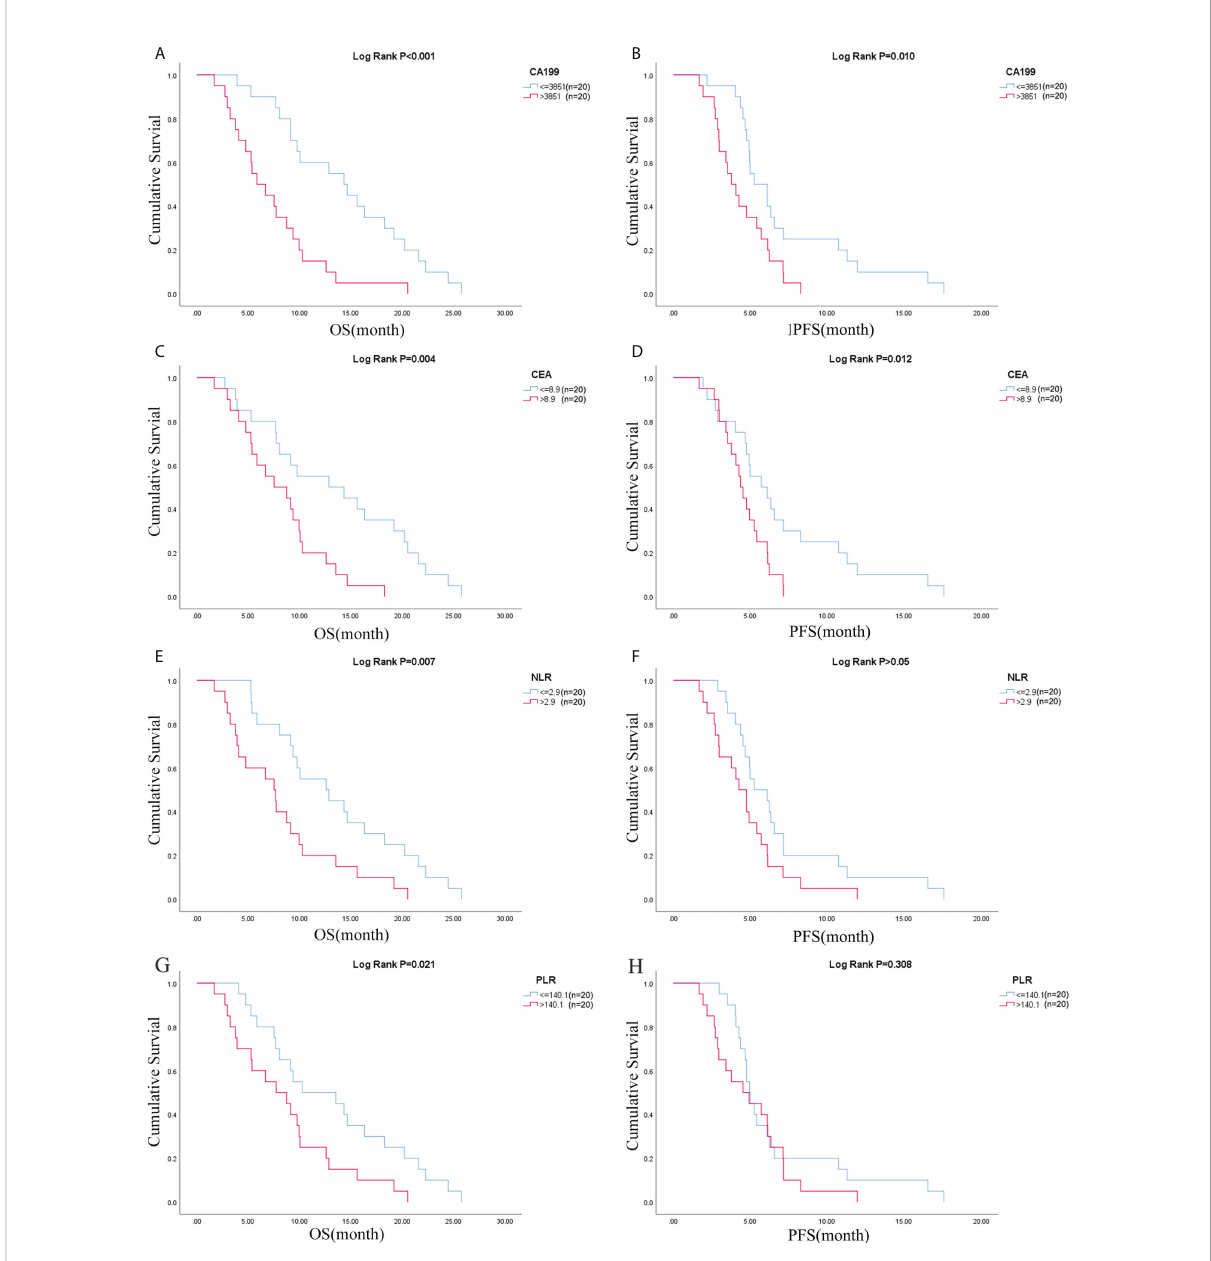
FIGURE 2 CA19-9 was associated with (A) OS and (B) PFS; CEA was associated with (C) OS and (D) PFS; NLR was associated with (E) OS and (F) PFS; PLR was associated with (G) OS and (H) PFS. OS, overall survival; PFS, progression-free survival; NLR, neutrophil-lymphocyte ratio; PLR, platelet- lymphocyte